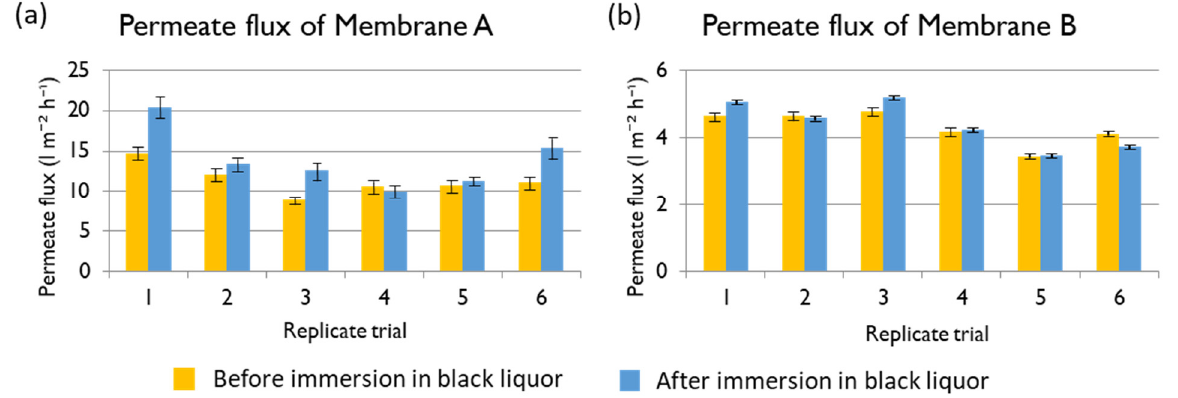
Figure 8. Permeate flux of Membranes A ( a ) and B ( b ) before and after the static test.